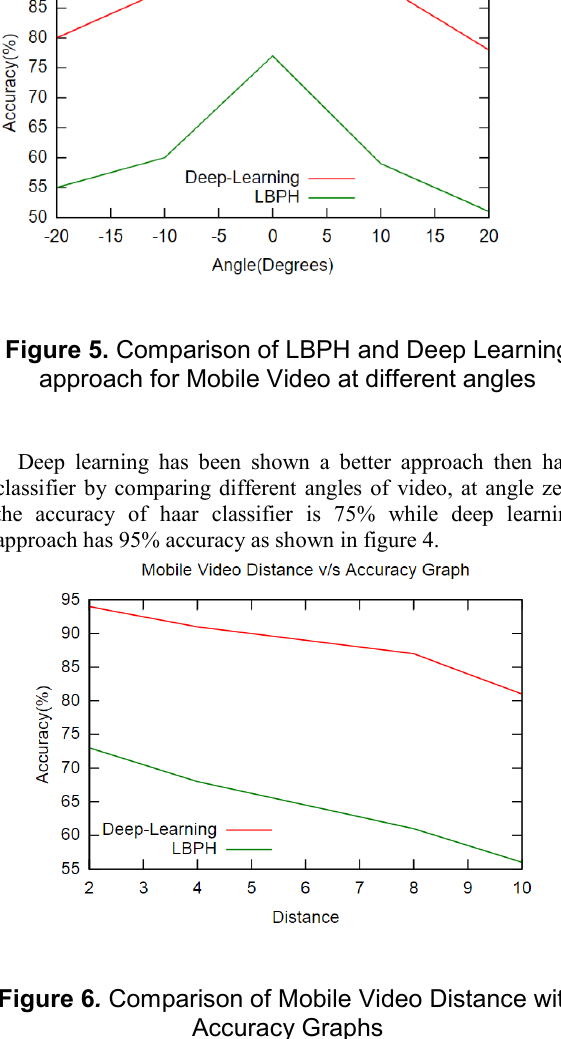
Figure 6 . Comparison of Mobile Video Distance with Accuracy